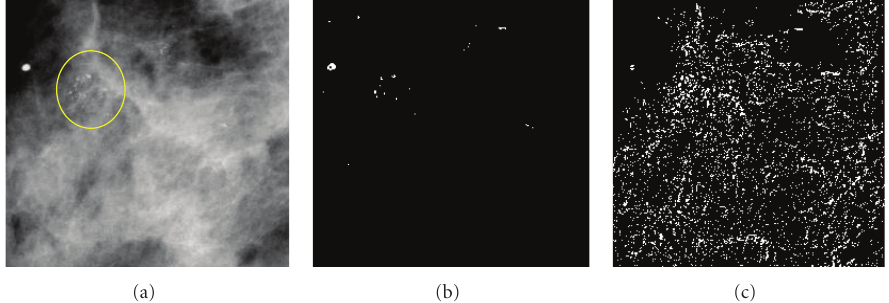
Figure 10: Detection results of MCs in a dense mammogram (mdb223) using di ff erent modeling constant K : (a) original mammogram (ROI of size 256 × 256 pixels, NMD = 0.05), (b) K = 0 . 25, (c) K = 0 . 1